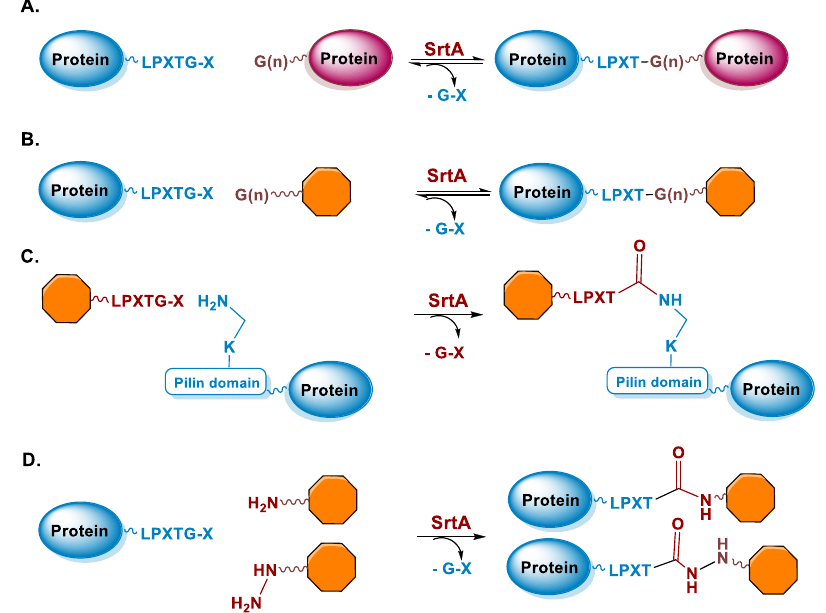
Figure 3. Reactions catalyzed by SrtA. ( A ) SrtA can catalyze the conjugation of a protein carrying the sortag sequence to another protein that has at the N-terminus an oligoglycine sequence. ( B ) The protein fused to sortag can be conjugated by SrtA to a cargo linked to an oligoglycine peptide. ( C ) The protein can also be fused to the pilin domain and it can be derivatized by SrtA with a ligand containing the sortag sequence. ( D ) Ligands containing primary amine or hydrazide groups can also be used.